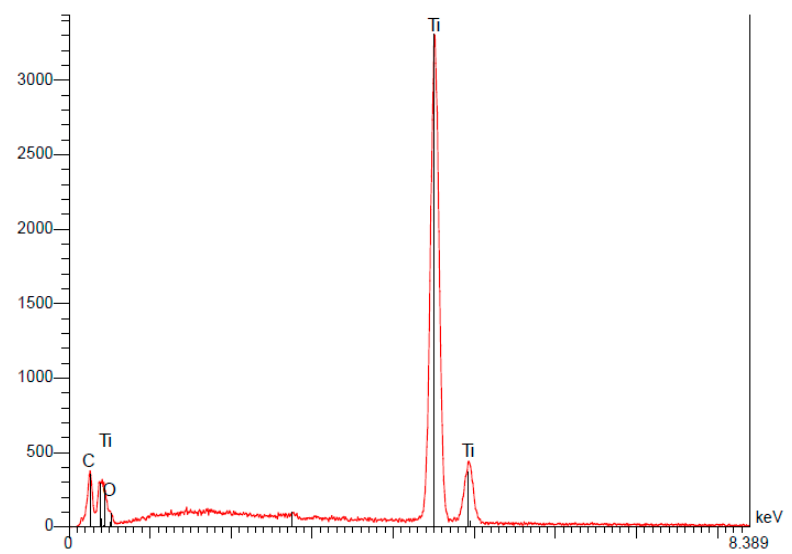
Figure 6. Spectrum of the Straumann implant. Table 4. The quantitative results of the EDS analysis of the Straumann implant demonstrating weight percentages (P%) and atomic percentages (A%) of the elements detected [15].